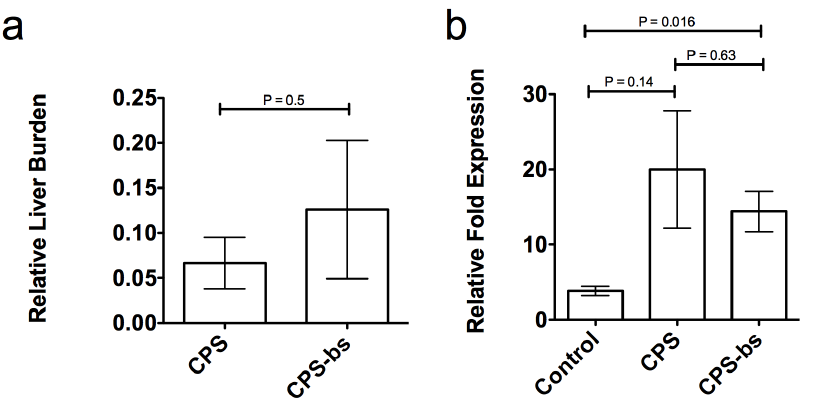
Figure 4. Figure 4a. Parasite liver load is not significantly different between CPS and CPS-bs groups. Animals (n=3) were subjected to CPS (CPS) or CPS under patency (CPS-bs) as described and subsequently challenged with 10,000 NK65 sporozoites at day 70 post-first-immunization. Mice were sacrificed after 46–48 hours and parasite liver burden was quantified by quantitative real-time PCR analysis of parasitic 18S rRNA expression and normalized to infected but unvaccinated control mice. Figure 4b. Both normal CPS and CPS-bs induce increased CD8 expression in the liver. Animals (n=4) were subjected to CPS (CPS) and CPS under patency (CPS-bs) as described and subsequently challenged with 10,000 NK65 sporozoites at day 70 post-first-immunization. Unvaccinated control mice (Control) were infected with 10,000 NK65 sporozoites. Mice were sacrificed after 46–48 hours and expression of CD8 was quantified by quantitative real-time PCR analysis.